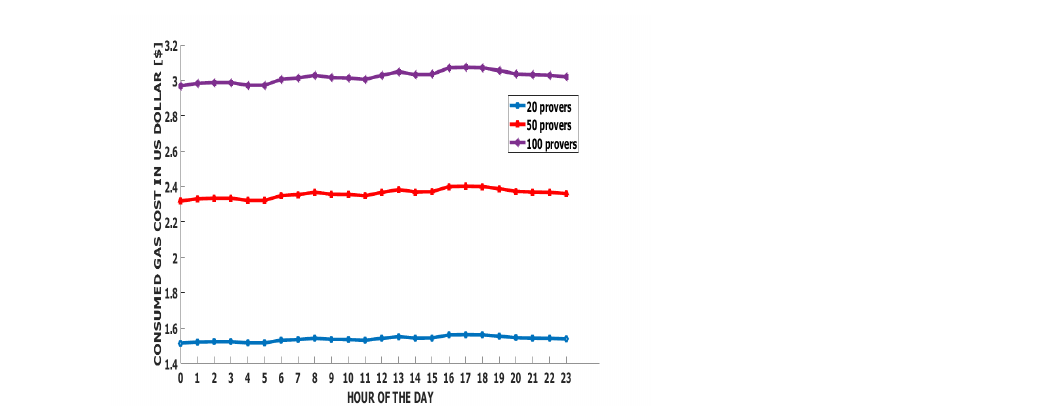
Figure 11. Execution cost of AC-OPF solution, cost in US dollars, depending on gas price fluctuation on 15 May 2022, using the proposed scheme.